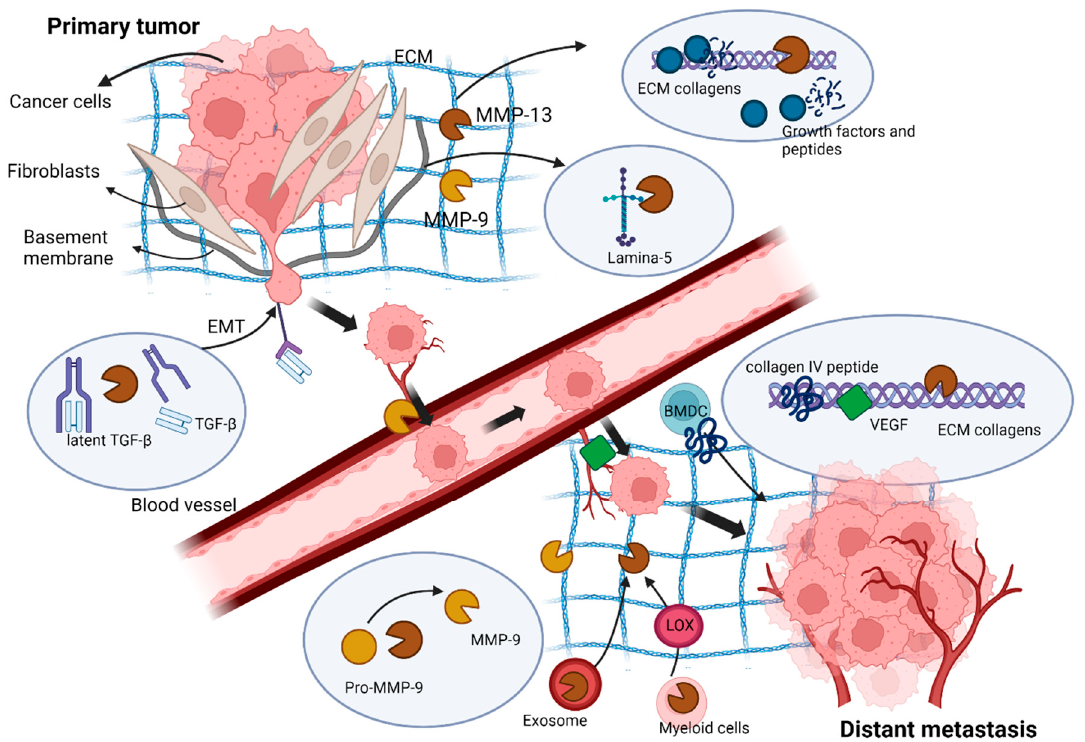
Figure 3. The action of MMP-13 in cancer progression and metastasis: MMP-13, produced by cancer cells and stromal fibroblasts, cleaves ECM and leads to ECM remodelling and liberation of ECM- bound growth factors and angiogenic factors that promote tumour cell proliferation, invasion, EMT and angiogenesis at primary tumour sites. At distant metastasis sites, MMP-13-mediated ECM remodelling and release of growth factors and collagen IV peptides help the recruitment of immune cells to the pre-metastatic niche and the establishment of a favourable metastasis environment.